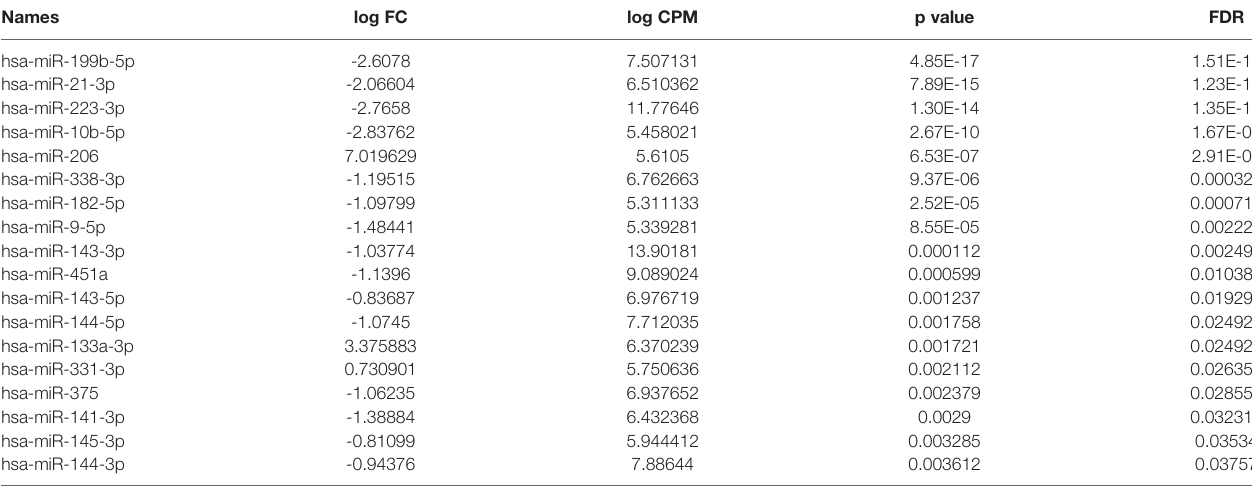
TABLE 3 | Differentially expressed miRNAs between CHB patients and controls in